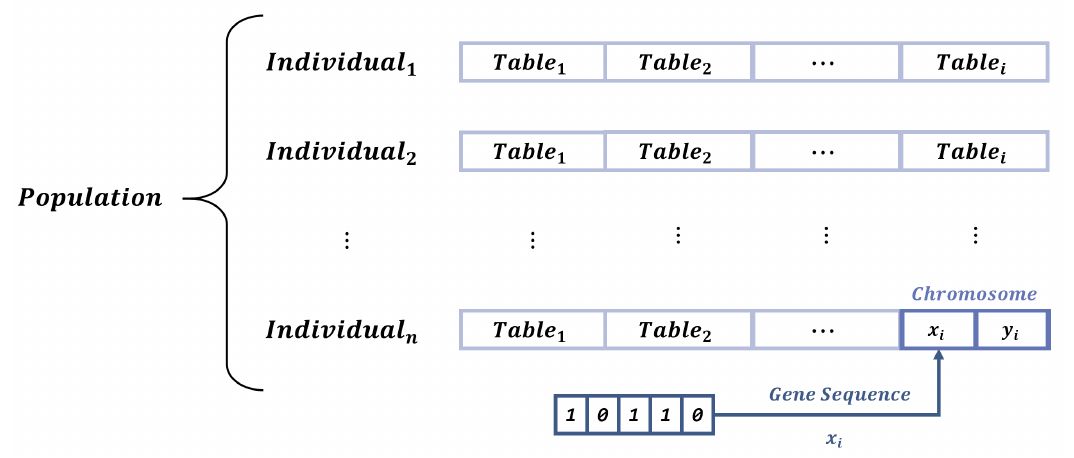
Figure 3. Binary codification of the population in the Genetic Algorithm (GA) proposed for the Table Location Problem